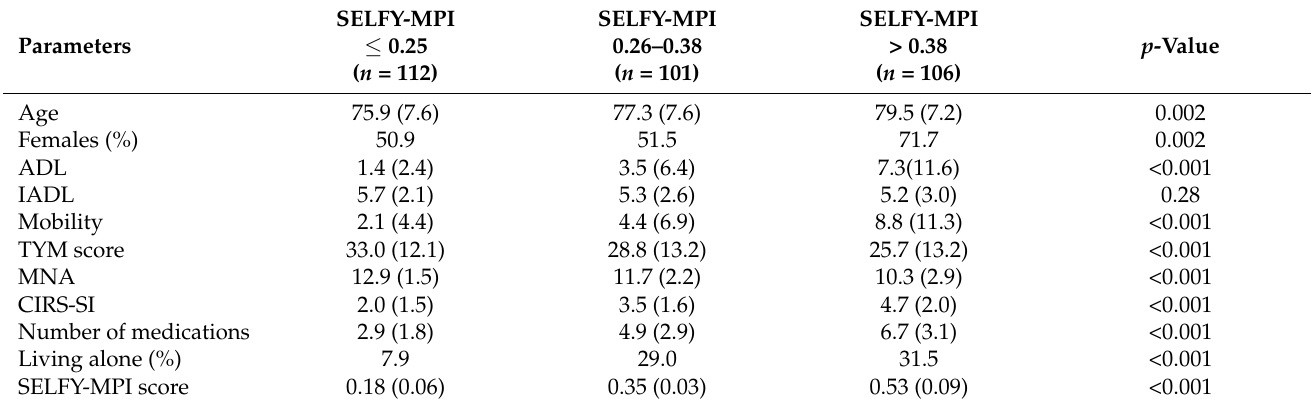
Table 1. Descriptive characteristics of the sample included by SELFY multidimensional prognostic index values.